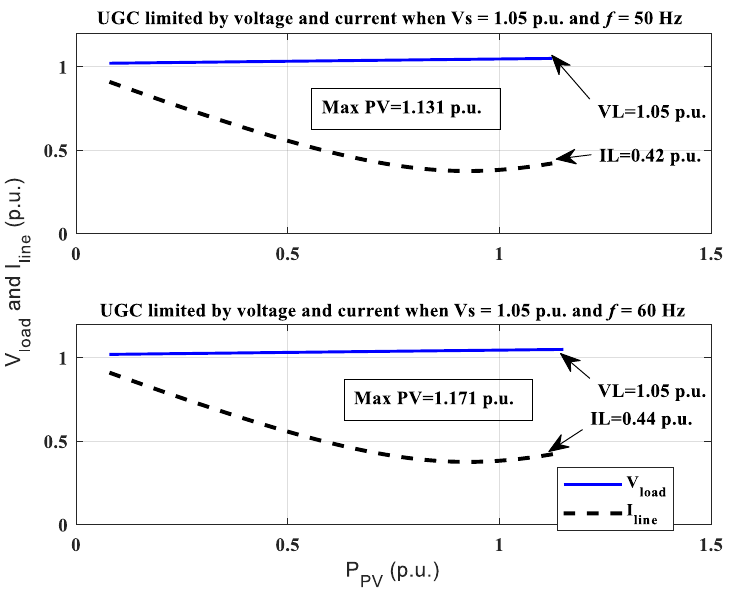
Figure 12. Effect of system frequency on maximum PV penetration limit for the UGC (Substation voltage 𝑉 𝑆 = 1.05 p.u. ).